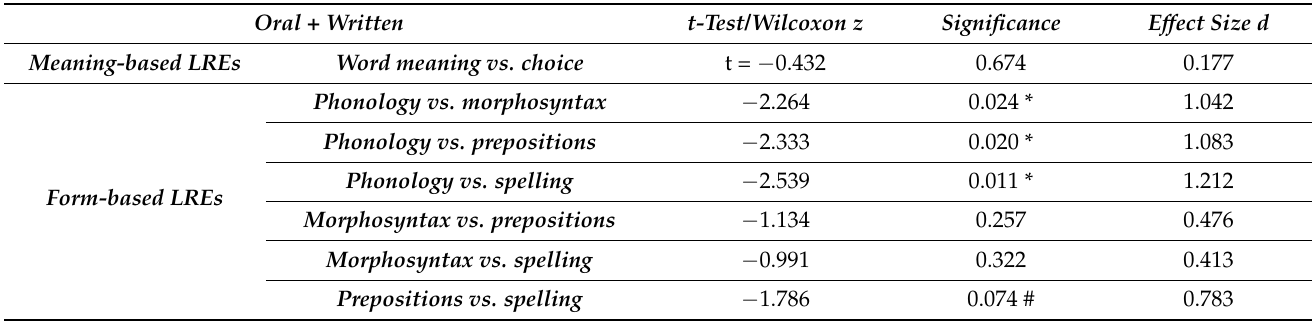
Table 3. Target comparisons for the production of LREs in the OW task.